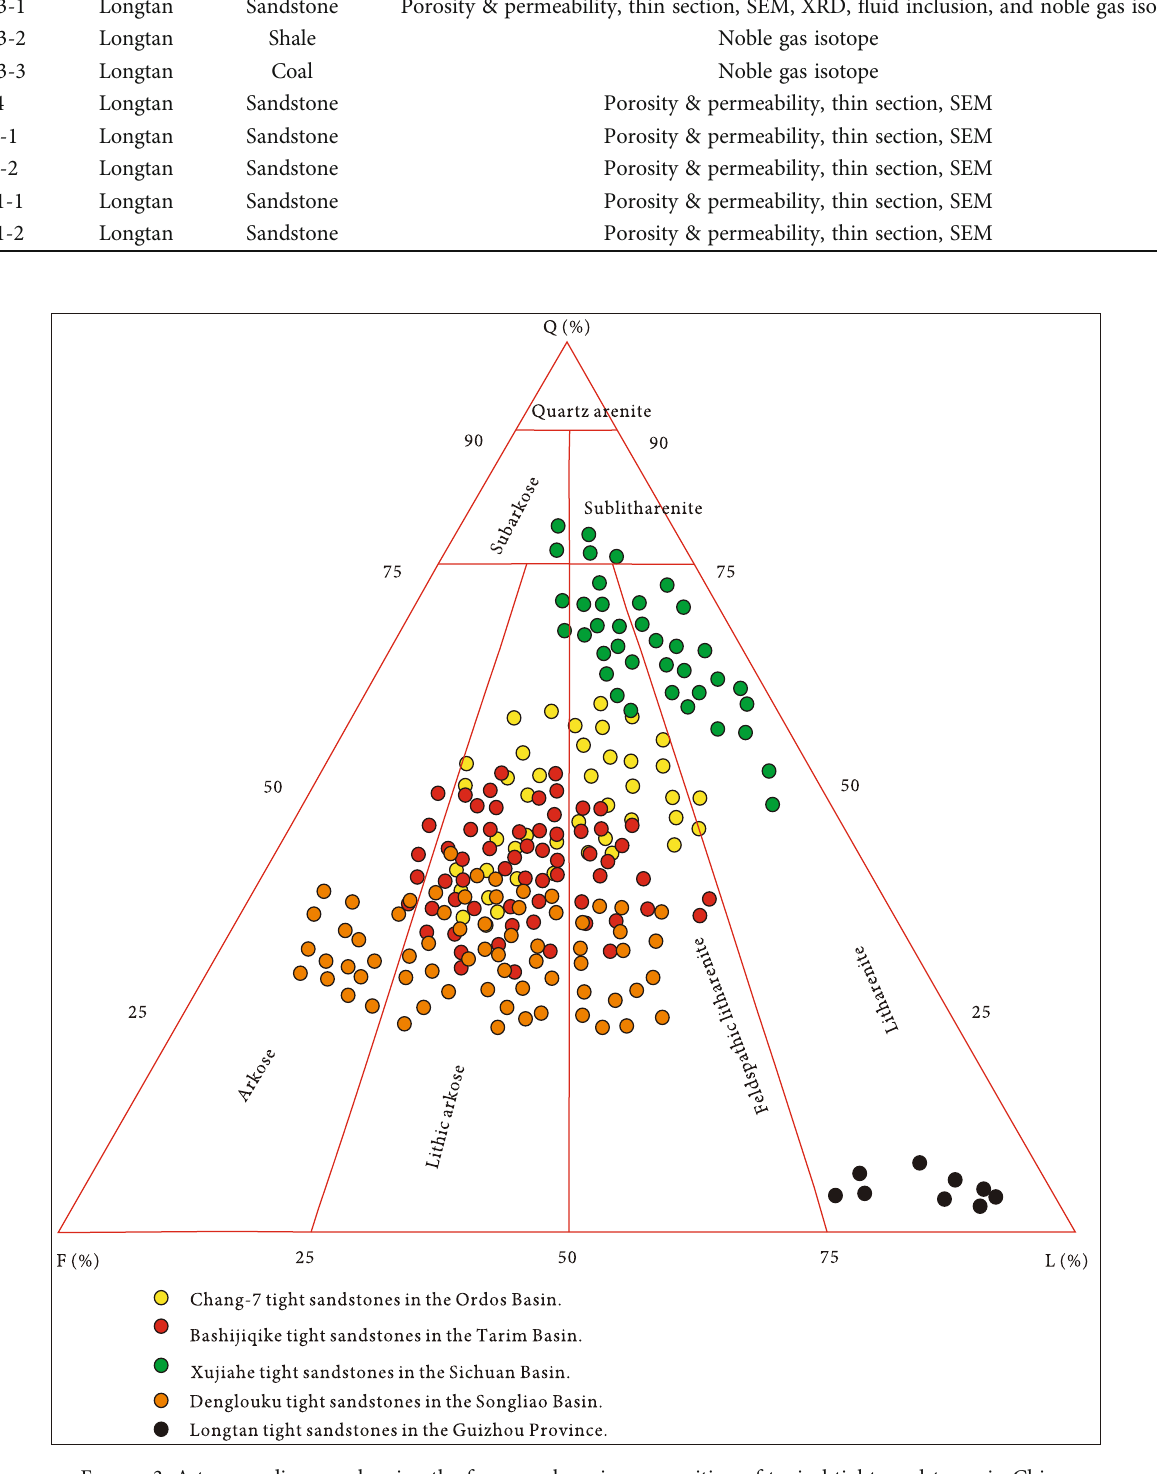
Figure 3: A ternary diagram showing the framework-grain composition of typical tight sandstones in